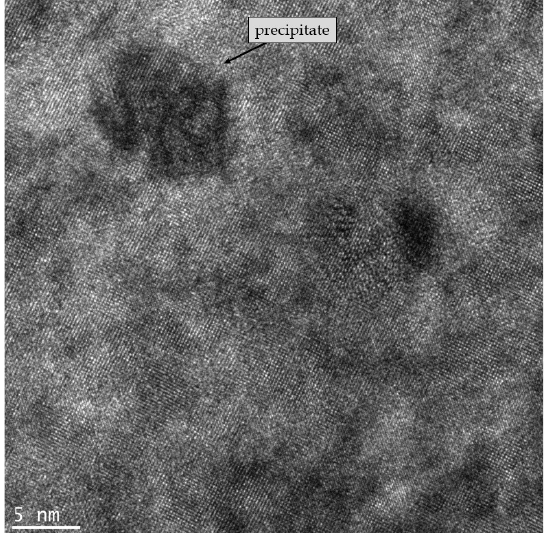
Figure 3. ( a ) BCC diffraction pattern with weaker superlattice spots. The orientation of the plane is (311). Brighter spots correspond to the Nb base BCC diffraction pattern plus precipitates, weaker spots only to the diffraction pattern of the precipitates. ( b ) Image of the particles based on the selection of a superlattice spot (dark field image). The two-hemispheric contrasts associated to each particle correspond actually to the strain field around the precipitates. The size of the precipitates is typically below 15 nm.